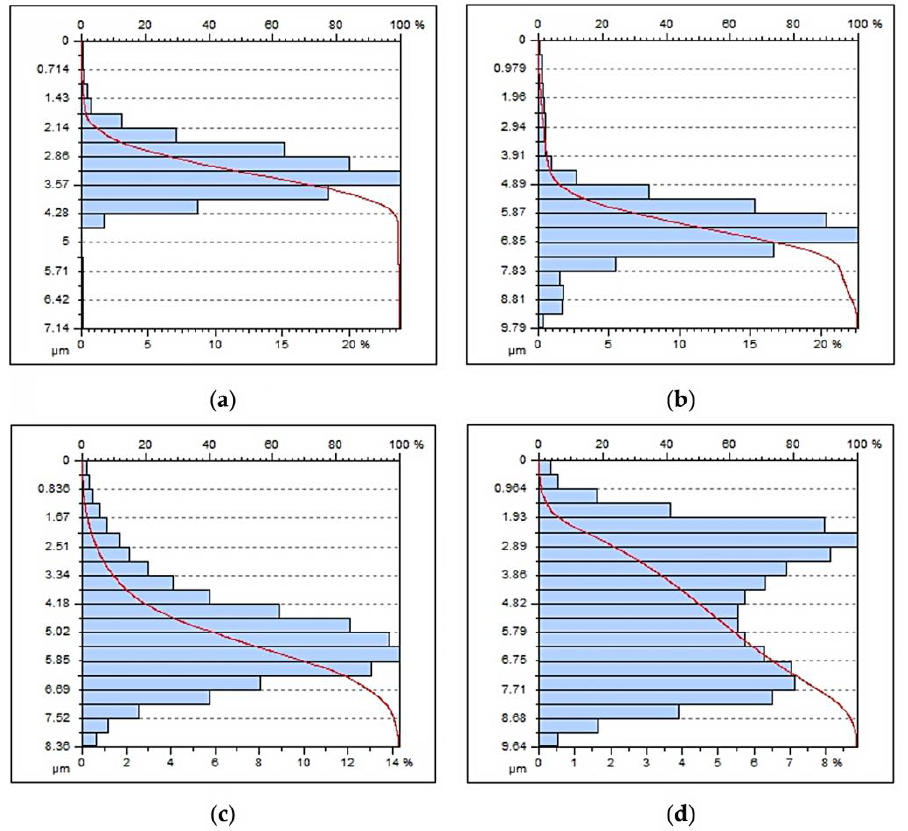
Figure 13. The material ratio as a function of the height, Abott-Fireston curve. ( a ) feed rate V f = 200 mm/min, ( b ) feed rate V f = 600 mm/min, ( c ) feed rate V f = 1000 mm/min, ( d ) feed rate V f = 1800 mm/min.